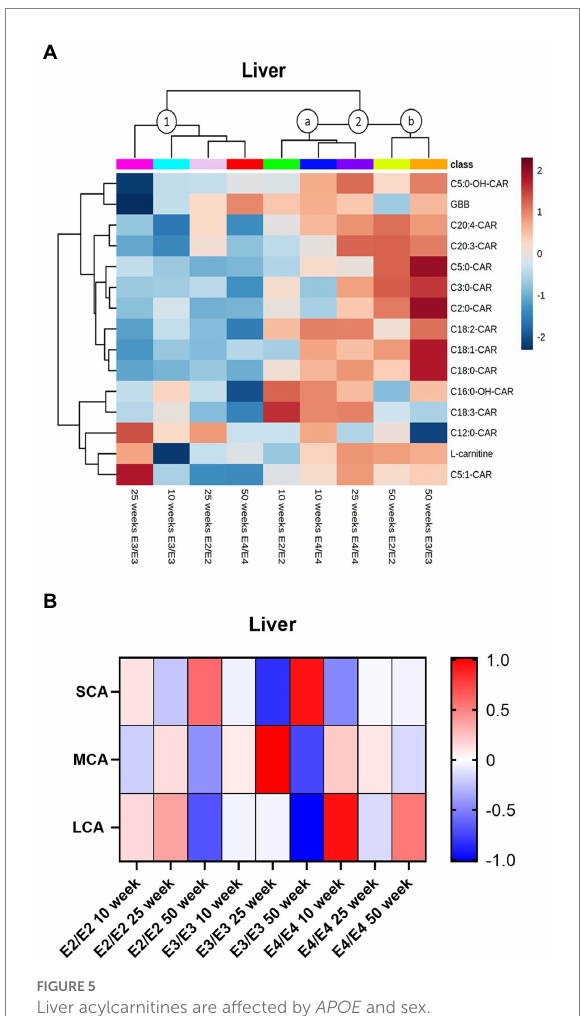
FIGURE 5 Liver acylcarnitines are affected by APOE and sex. (A) Hierarchical clustering heatmap showing acylcarnitine species with APOE genotypes at different age timepoints in the liver. (B) Z-score heatmap showing acylcarnitine chain length ratios to total acylcarnitines with APOE genotypes at different age timepoints in the liver. Statistics: For the clustering heatmap data were normalized and scaled before being analyzed using Ward’s clustering, with the top 15 acylcarnitines selected by ANOVA. Multiple comparisons with B-H correction were performed on the data. Numbers per group; 10-week APOE2- TR n = 6, 25-week APOE2-TR n = 5, 50-week APOE2-TR n = 6, 10-week APOE3-TR n = 6, 25-week APOE3-TR n = 5, 50-week APOE3-TR n = 6, 10-week APOE4-TR n = 6, 25-week APOE4-TR n = 6, 50-week APOE4-TR n = 4. Cx:y-CAR, acylcarnitines; Cx:y- OH-CAR, hydroxy acylcarnitines; GBB, γ -butyrobetaine; LCA, long chain acylcarnitines; MCA, medium chain acylcarnitines; SCA, short chain